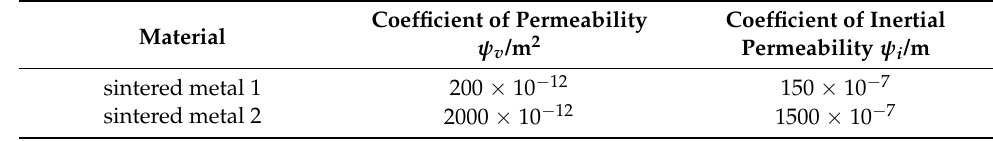
Table 1. Material properties of sintered metals.